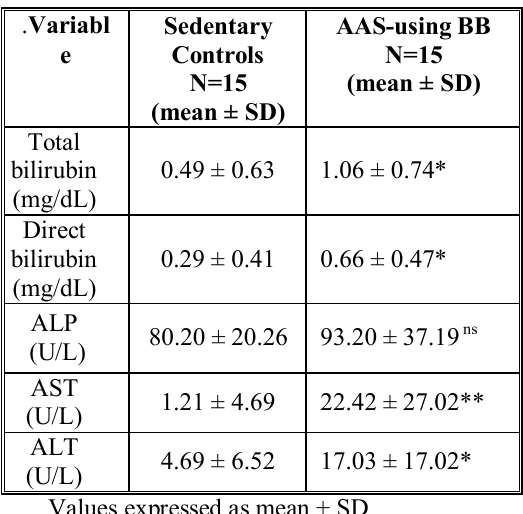
Table 3: Effects of anabolic androgenic steroids on liver function tests in AAS-using bodybuilders compared to sedentary controls.